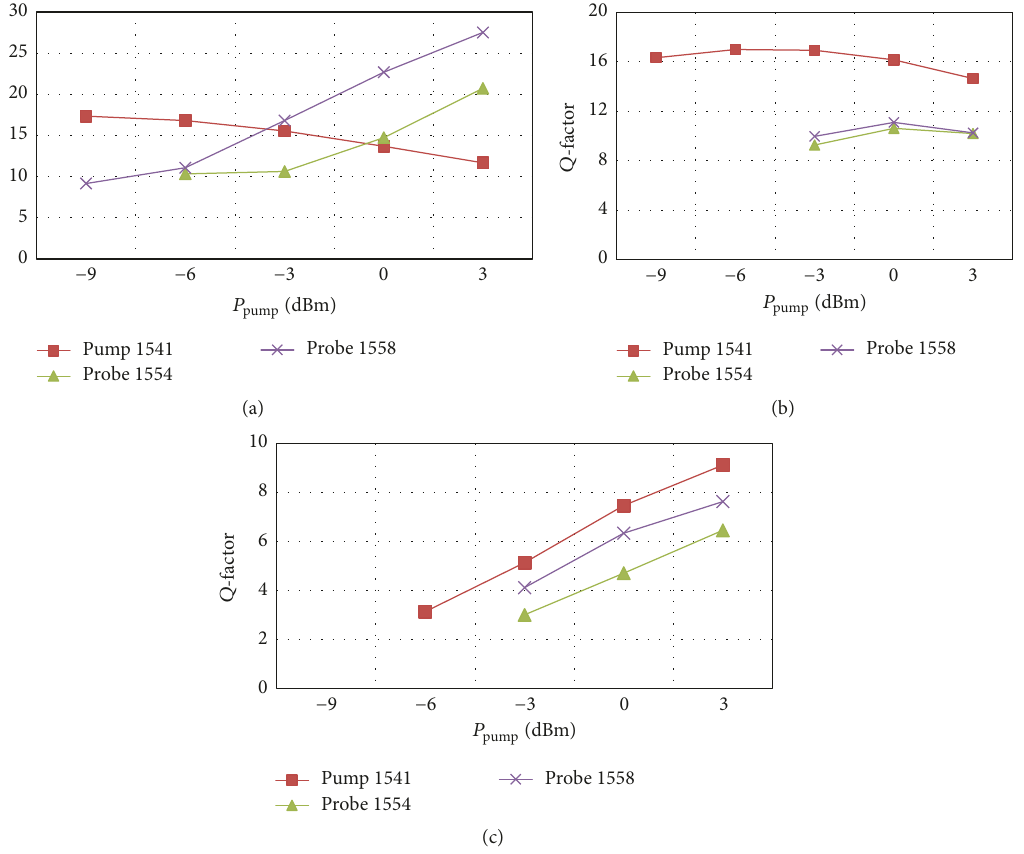
Figure 3: Impact of pump power: (a) fiber to fiber, (b) after 20 km fiber link, and (c) after 20km + optical